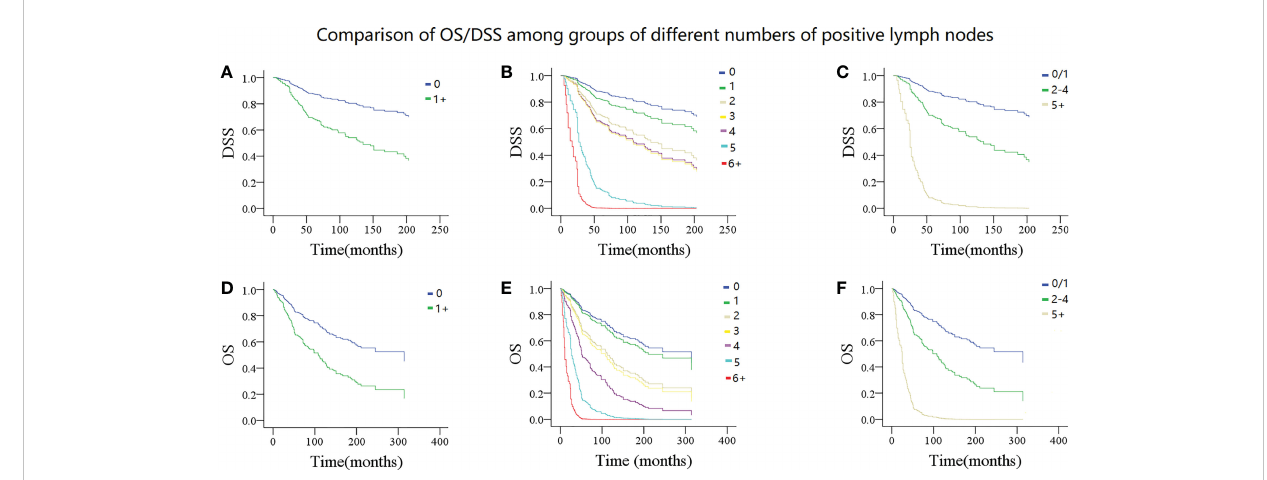
FIGURE 2 Comparison of disease speci fi c survival (DSS) and overall survival (OS) in patients with different numbers of positive lymph nodes. DSS: (A) 0 vs 1+; (B) 0 vs 1 vs 2 vs 3 vs 4 vs 5 vs 6+; (C) 0/1 vs 2-4 vs 5+; OS: (D) 0 vs 1+; (E 0 vs 1 vs 2 vs 3 vs 4 vs 5 vs 6+; (F) 0/1 vs 2-4 vs